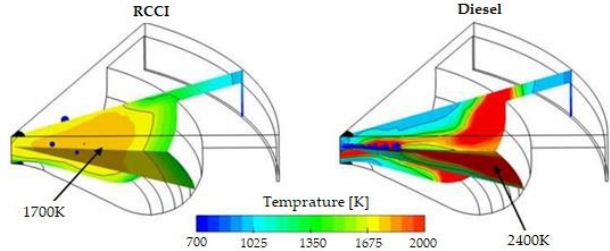
Fig. 8. Temperature distribution in the combustion chamber for a RCCI engine powered by CNG and diesel and a classic diesel engine powered only by diesel (modified graphic based on [7])